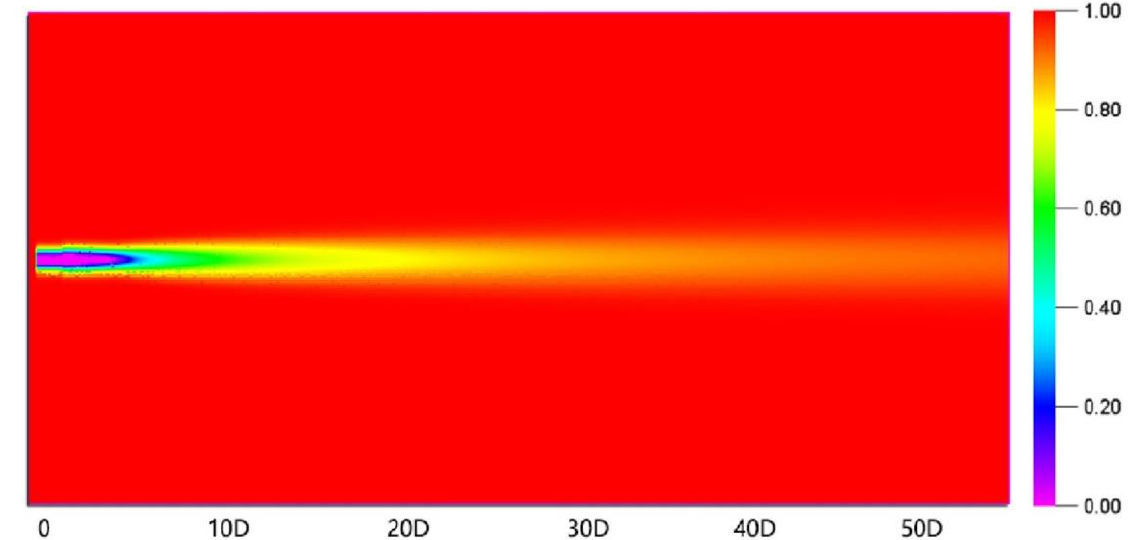
Figure 5. Single wake wind speed by Eddy-Viscosity wake model.